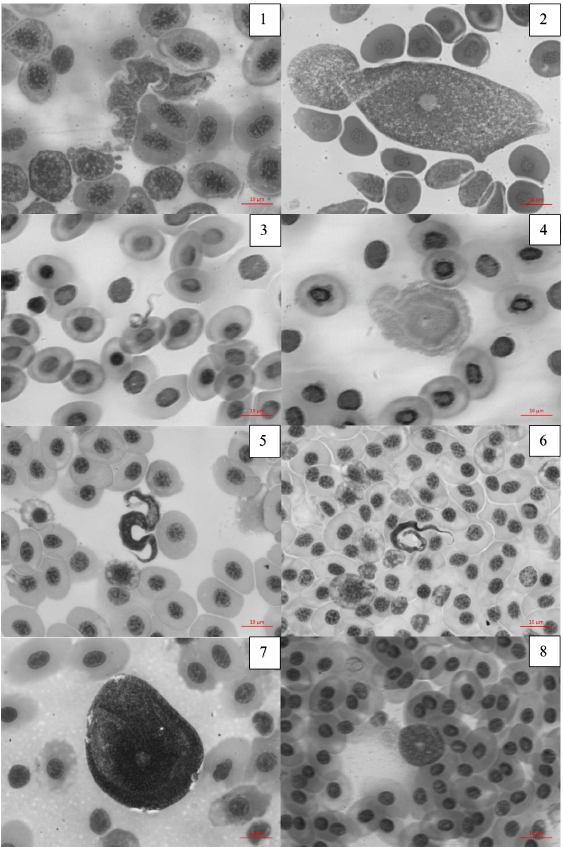
Figure 2. Characterization of Trypanosoma parasites found in anurans from forest areas and oil palm plantations in the municipality of Tailândia, Pará, Brazil. 1) Group A ( Osteocephalus oophagus ); 2) Group A ( Scinax gr. ruber ); 3) Group B ( Leptodactylus fuscus ); 4) Group C ( Physalaemus ephippifer ); 5) Group D1 ( Leptodactylus macrosternum ); 6) Group D2 ( L. macrosternum ); 7) Group F ( Boana geographica ); 8) Group F ( L. macrosternum ). Scale = 10 µm. Species between parentheses = region, starting from the kinetoplast, which narrows later (Figure 2: 3); Group C: Robust body, frontally compressed and ovoid; laterally robust, elliptical, about twice as long as it is wide (Figure 2: 4); Group D: Elongated body, narrow extremities; D1: Kinetoplast closer to the nucleus than to the posterior end (Figure 2: 5); D2: Kinetoplast closer to the posterior end than to the nucleus (Figure 2: 6); Group F: Spherical body (Figure 2: 7, 8). Apicomplexa hemoprotozoans